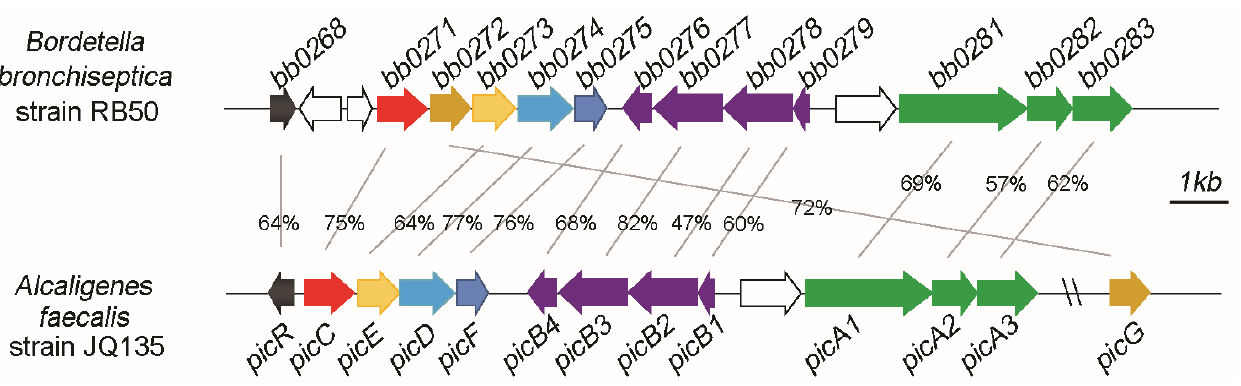
Figure 1. Organization of the pic gene clusters of B. bronchiseptica RB50 and A. faecalis JQ135. The bb0268-bb0283 indicate the gene IDs of pic genes in strain RB50. Numbers between the arrows indicate the percent amino acid sequence identities between strains RB50 and JQ135.